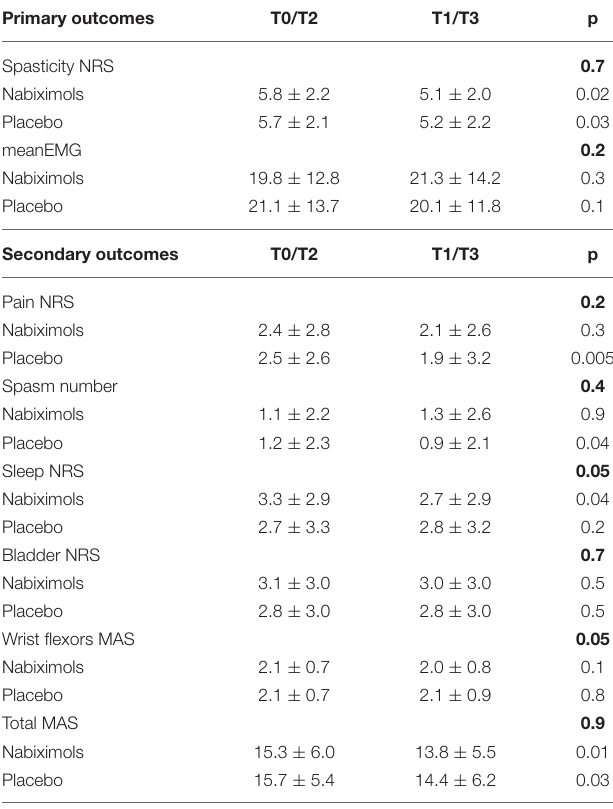
TABLE 3 | Primary and secondary